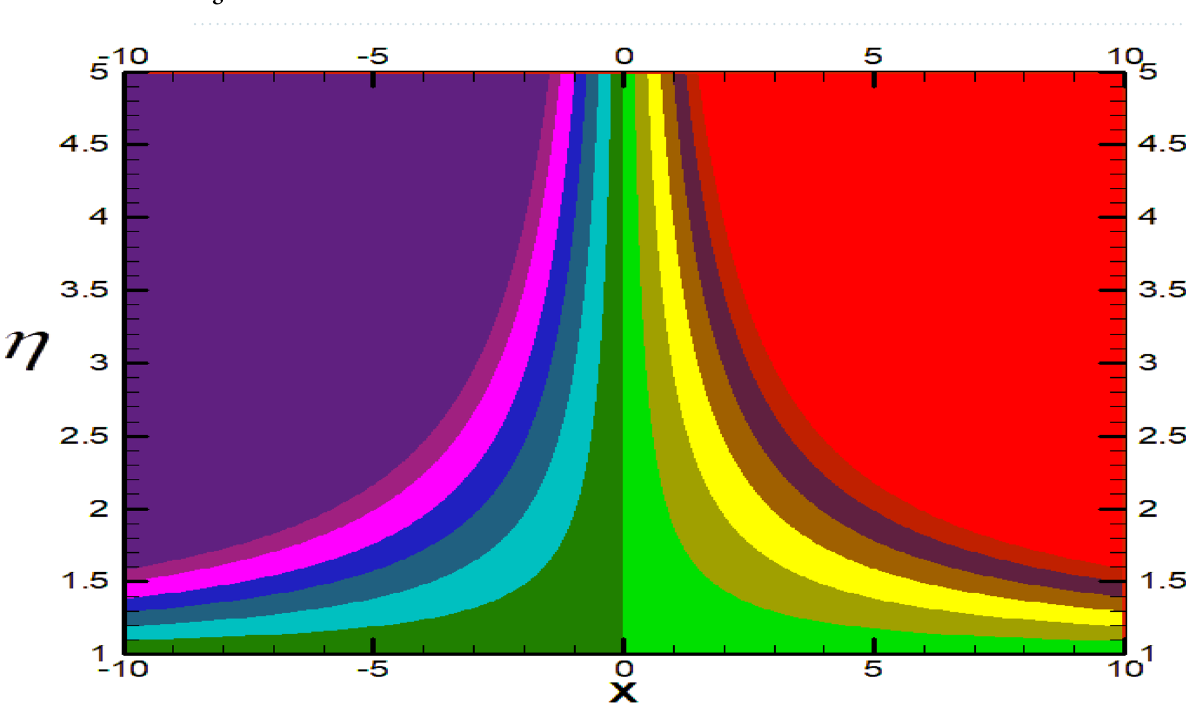
Figure 27. Streamlines for (cid:31)